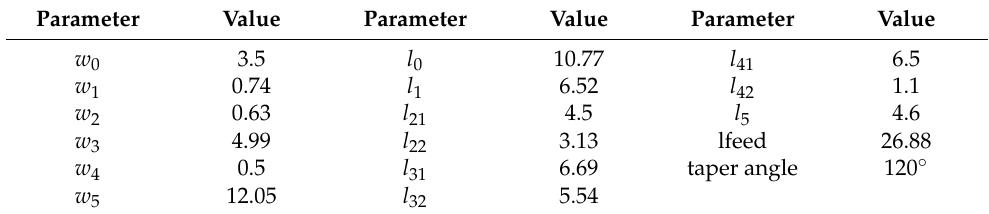
Table 2. Antenna parameters (unit: millimeters).